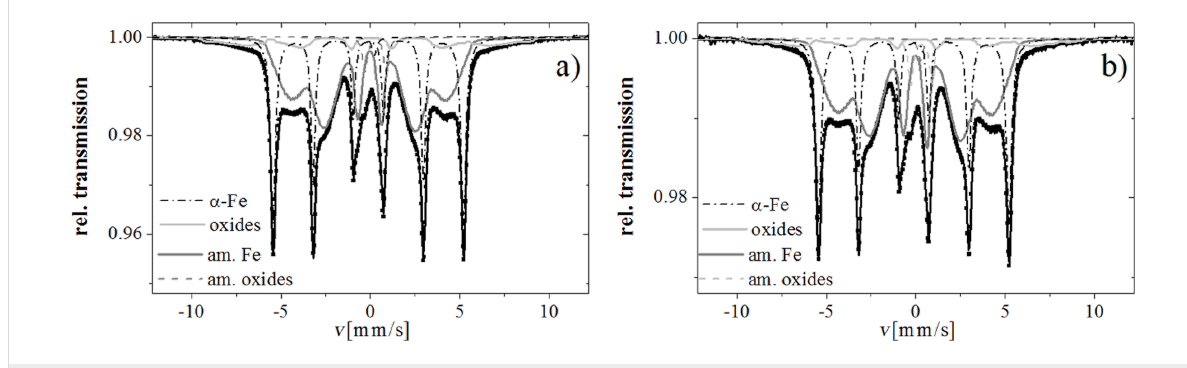
Figure 4: Mössbauer spectra of a) iron nanowires and b) iron nanoparticles and their main subspectra.